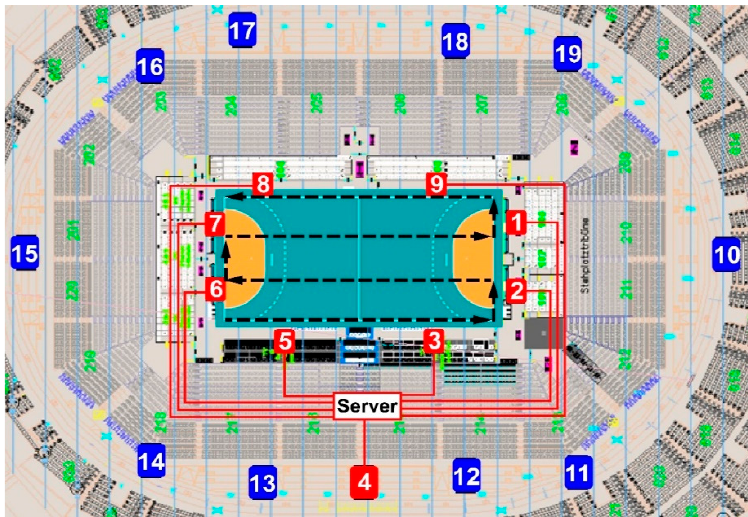
Figure 1. Local positioning system (LPS) setting: nine antennae connected to the server in red locations; ten reference antennae (anchors) in blue locations; meander path inside the field followed to check calibration accuracy (black discontinued line).